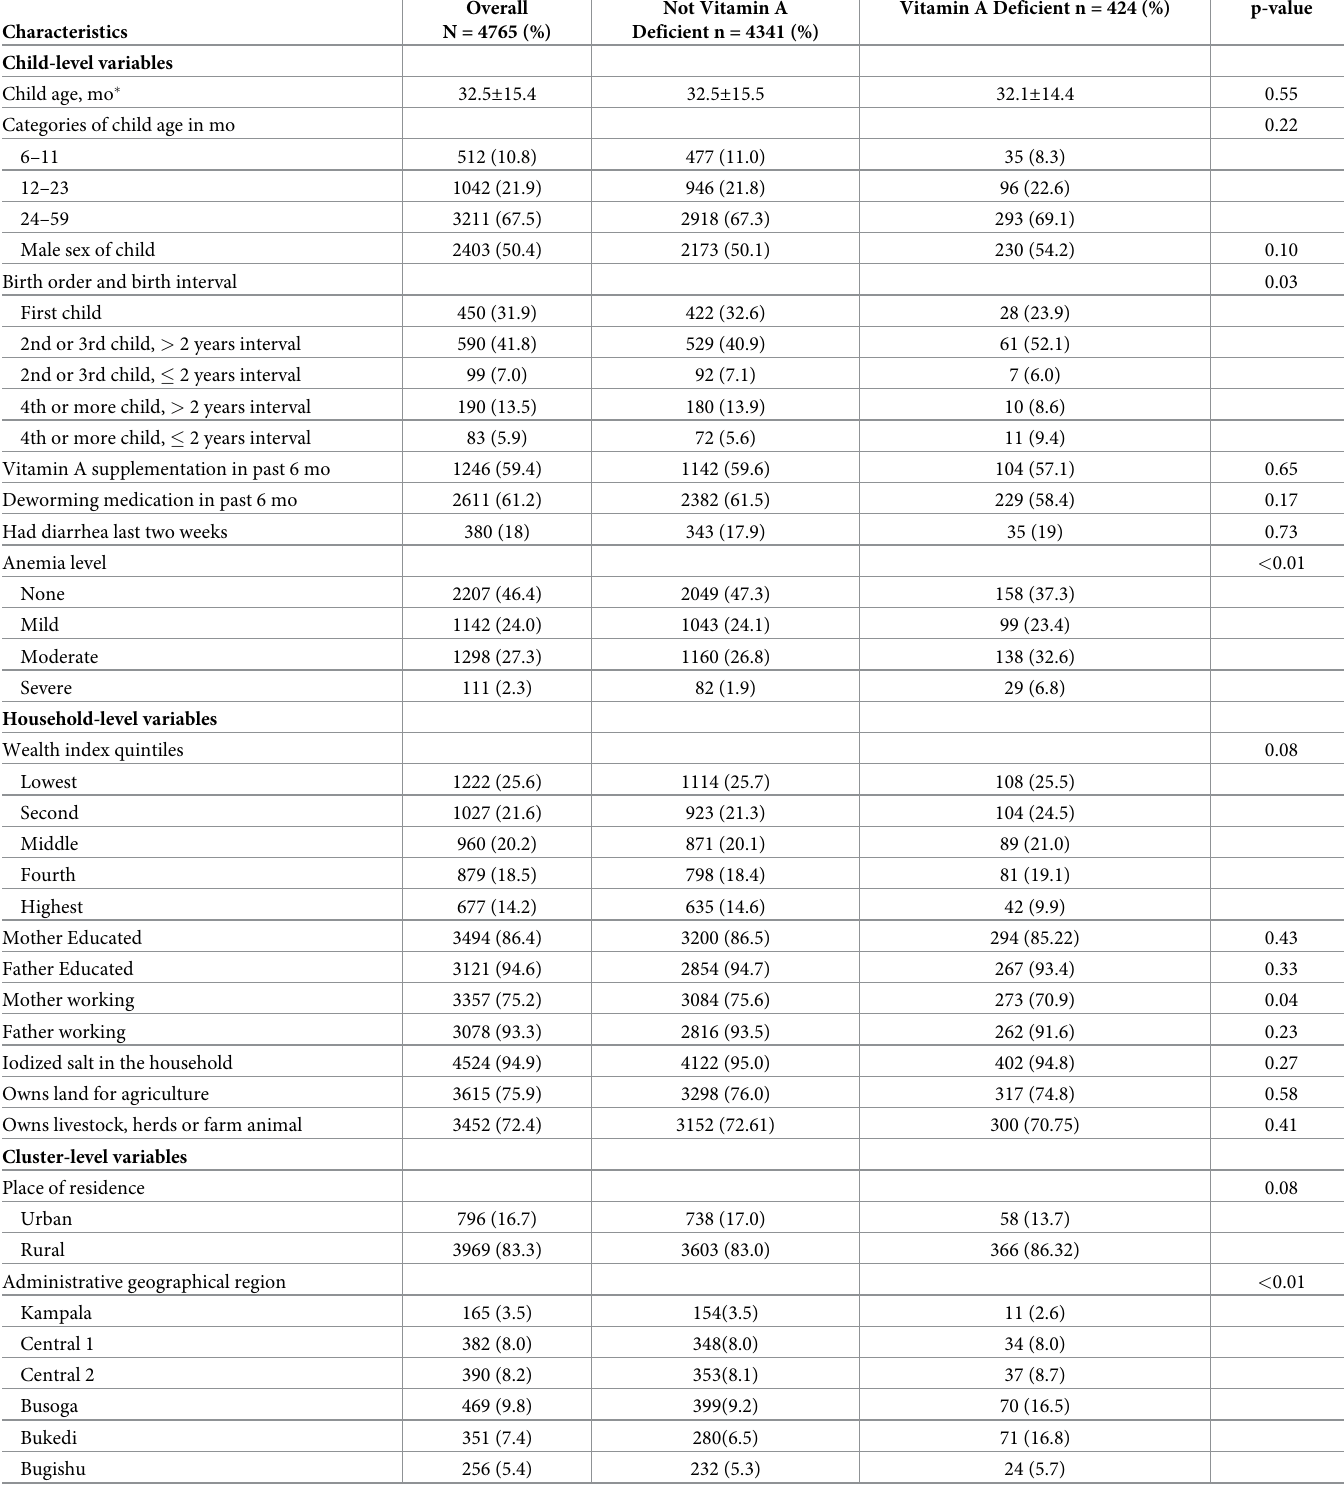
Table 1. Background characteristics of the survey